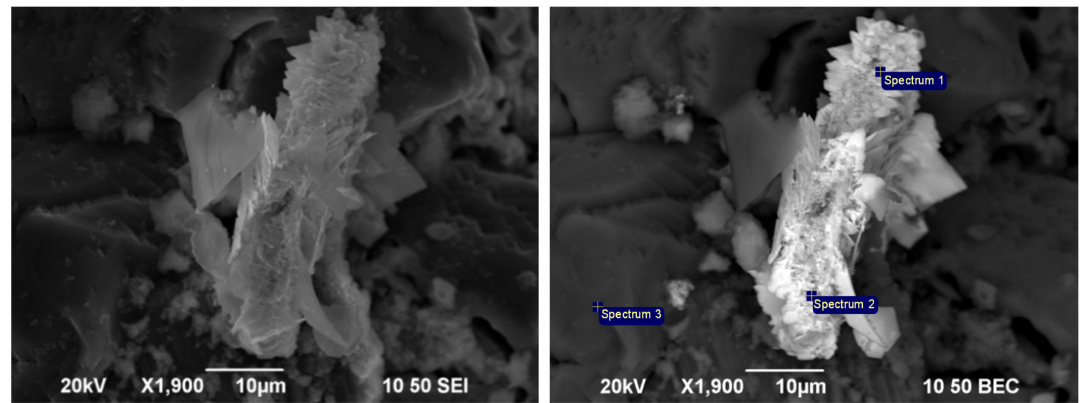
Figure 11. SEM secondary electron image ( left ) and corresponding backscattered electron image with three marked points for saturated FeZHg ( right